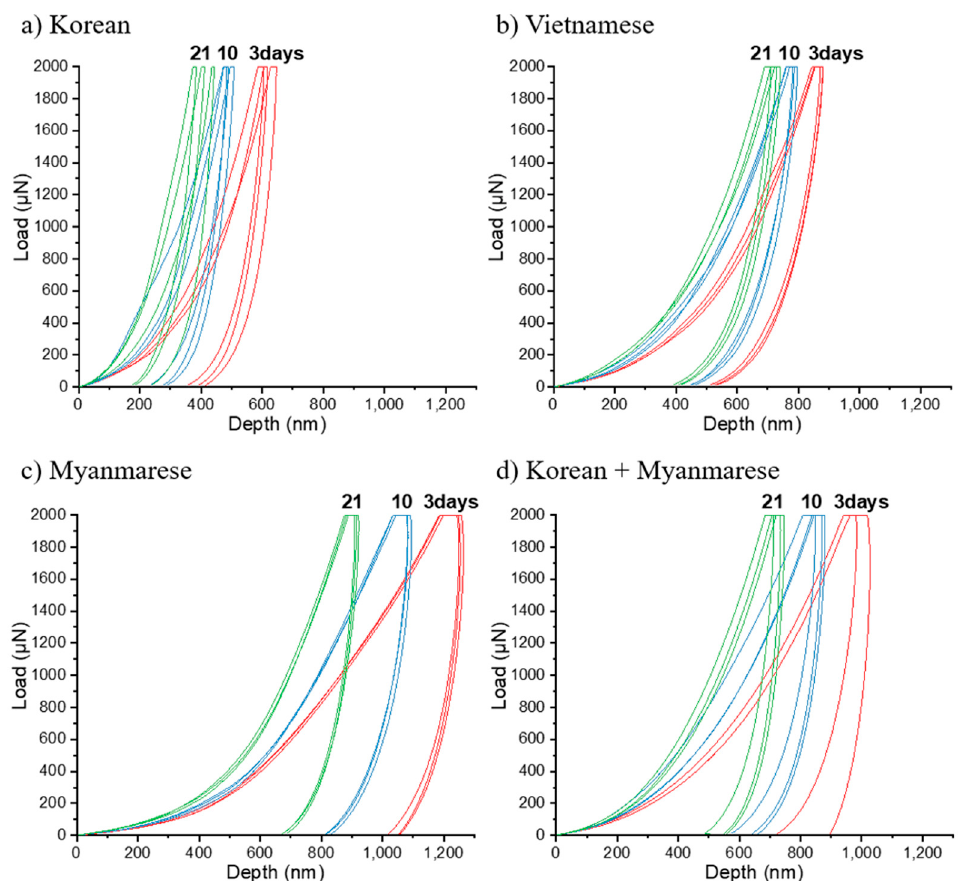
Figure 5. Force–displacement curve measurements with a nanoindenter for Oriental lacquer films in accordance with